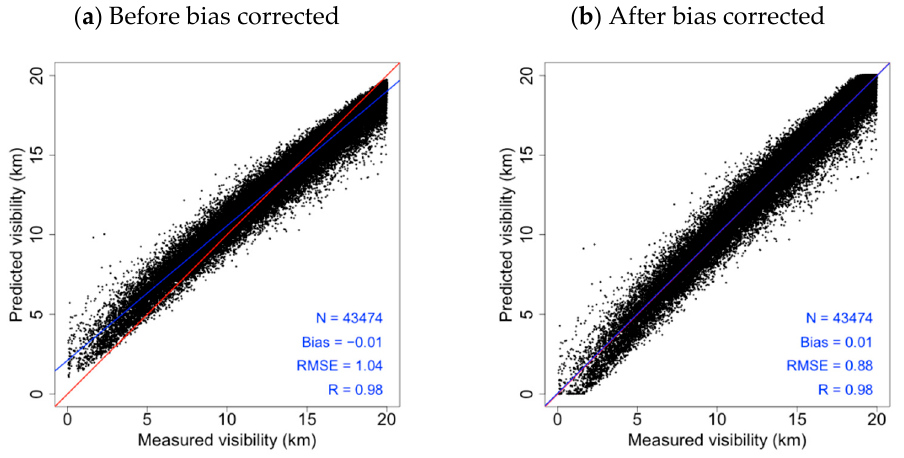
Figure 4. Scatter plot of VIS ASOS and original VIS RF ( a ) and bias-corrected VIS RF ( b ). The red line represents the 1:1 line and the blue line represents the regression line.